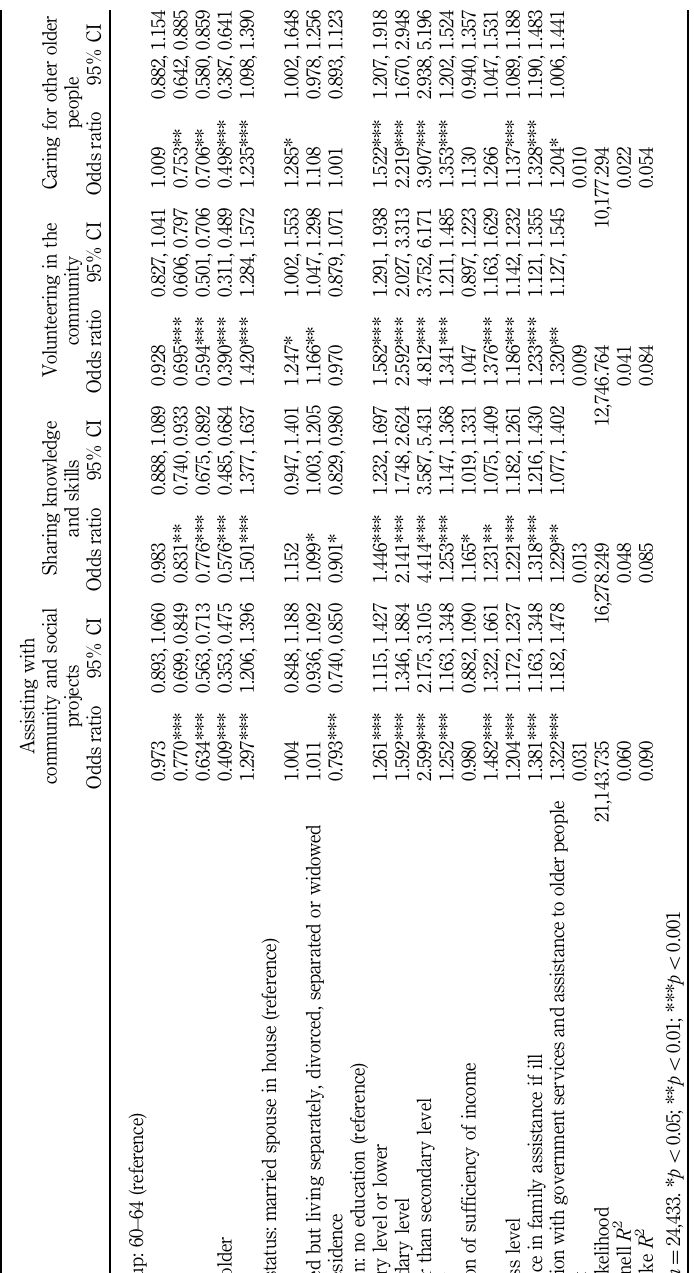
Table III. Results of the